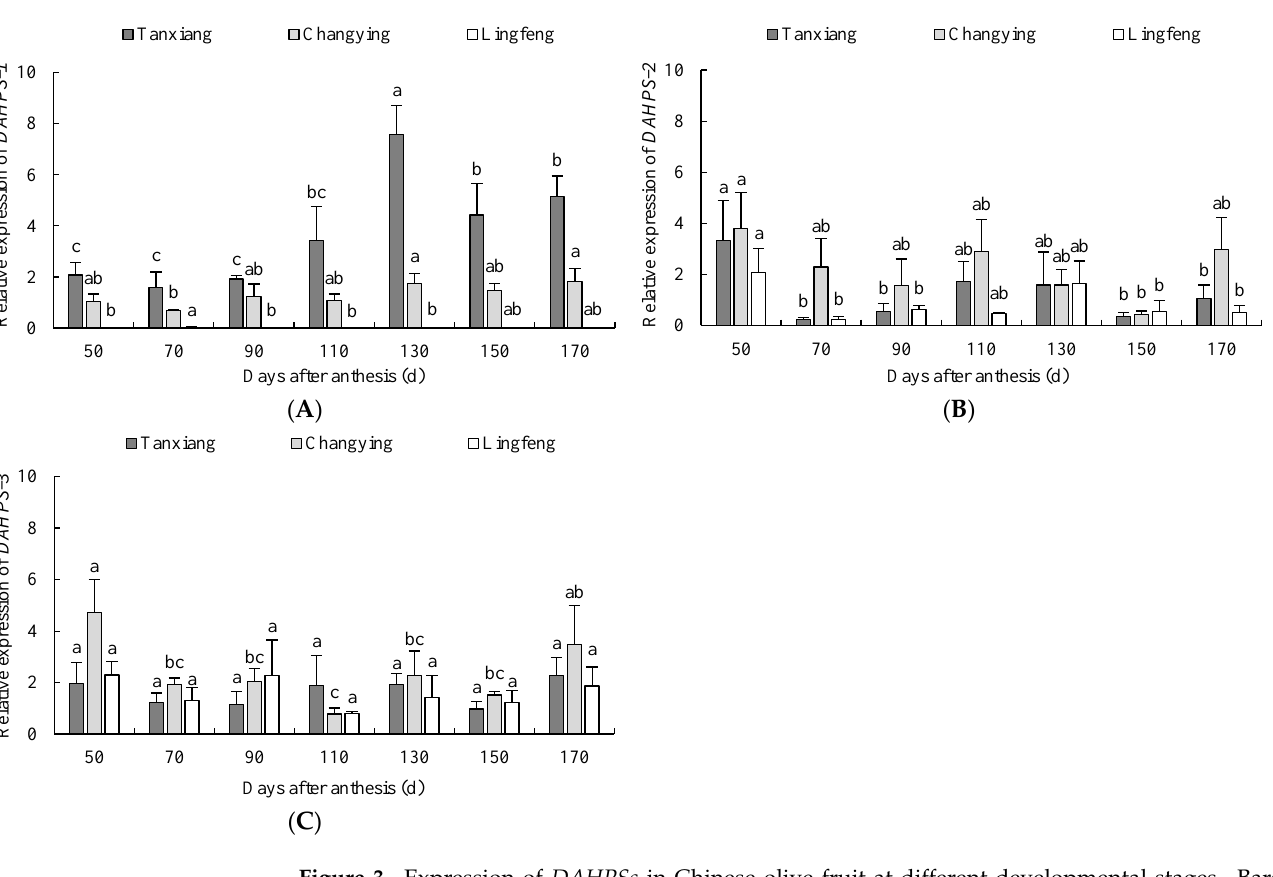
Figure 3. Expression of DAHPSs in Chinese olive fruit at different developmental stages. Bars represent the standard deviation for three biological replicates. Different letters indicate significant differences among different stages of the same cultivars ( p < 0.05). ( A ) DAHPS-1 , ( B ) DAHPS-2 and ( C ) DAHPS-3 .